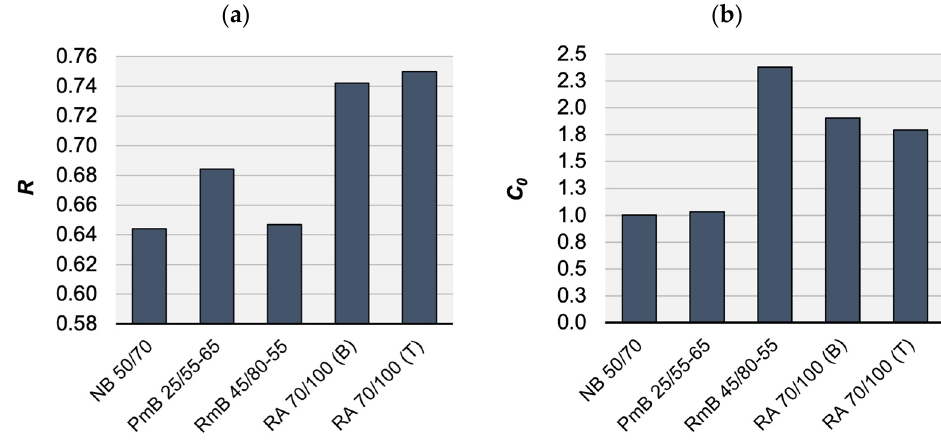
Figure 6. RAMBO model parameters of analysed mixtures: ( a ) average R curvature and ( b ) average C 0 shift by mixture type.